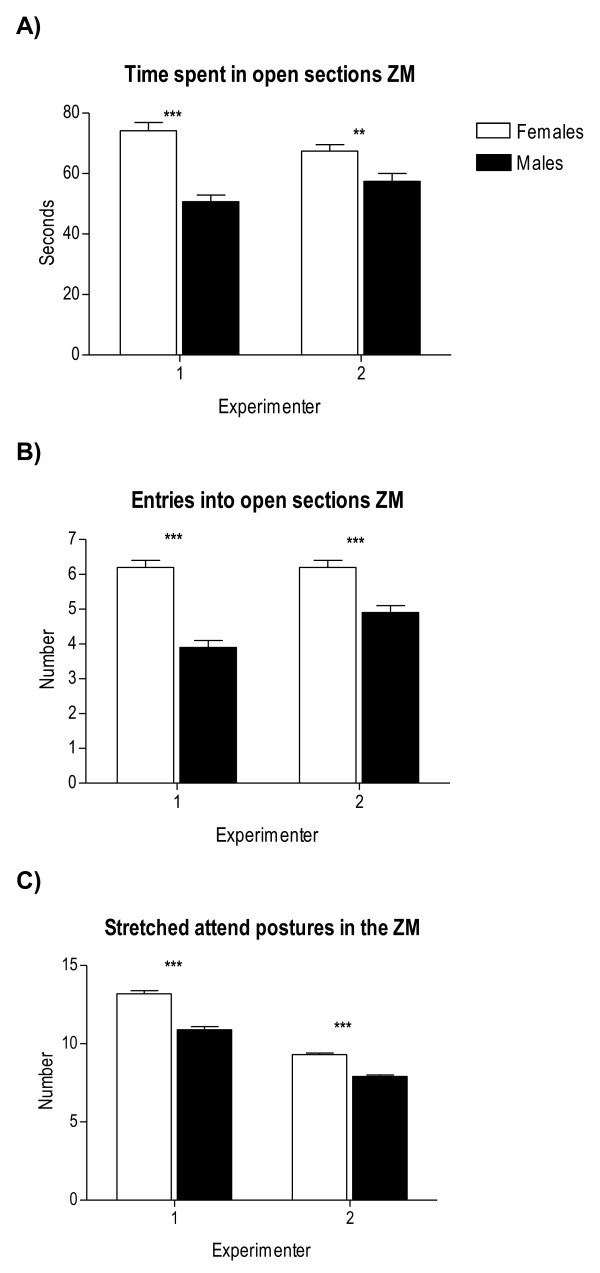
Between-sex differences in unconditioned anxious behaviour in the ZM test as a function of "experimenter"(see text for "experimenter" statistical effects). All other details as in Figure 1.